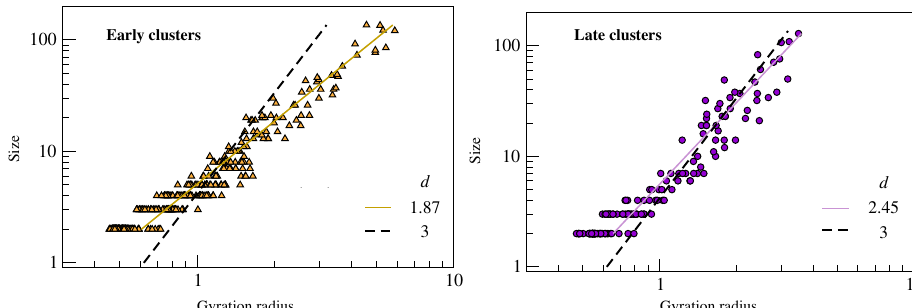
Figure 7. Correlation plot between the size M and the gyration radius R g of all clusters found in the early ( left ) and late ( right ) fractions of the six states of the liquid under study. The black dashed lines are the best-fit curves according to Equation (7) with d = 3 by adjusting the parameter c only. The continuous lines are the best-fit curves according to Equation (7) by adjusting also the fractal dimension d . We find d = 1.87 ( 2 ) and d = 2.45 ( 3 ) for the early and late clusters,